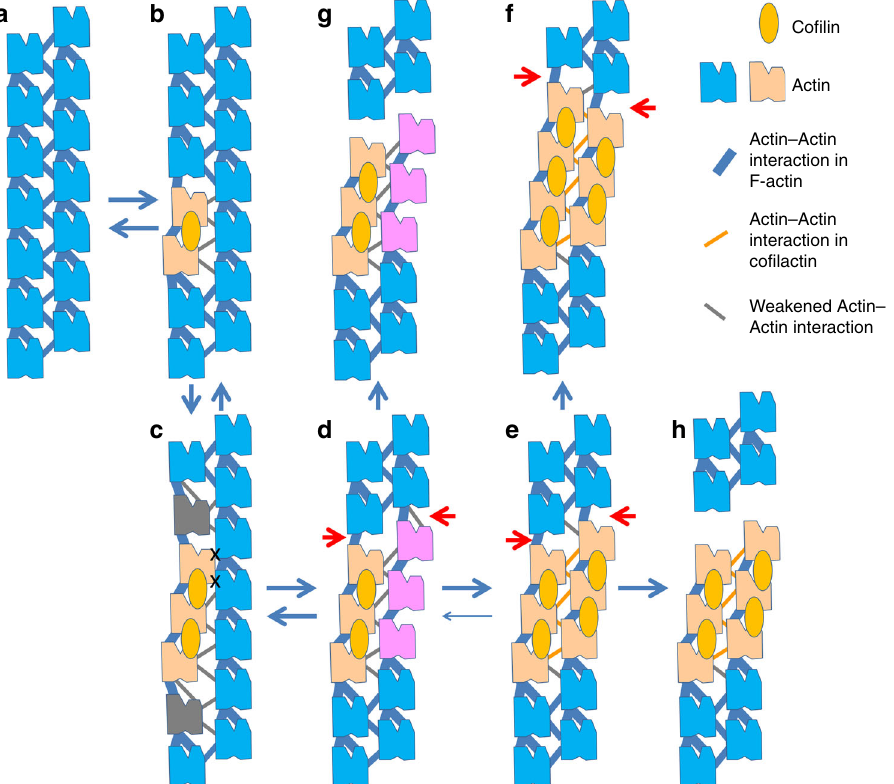
Fig. 7 Model for severing. The P-end is at the top. a F-actin. The F-form actin subunits are represented in blue. The intrastrand actin-actin contact is represented by a pair of thick blue lines, one for the ID – ID interactions and the other for the OD – ID interactions. The interstrand actin-actin contacts are also represented by thick blue lines. b Upon binding of the fi rst co fi lin molecule (orange oval) to one strand of the F-actin, two actin subunits undergo conformational transition into the C-form (camel), which is associated with a twist change in the actin strand, and therefore changes in relative positions of subunits. We assume that these positional changes weaken the interstrand contacts, as indicated by the thin gray lines. c The second co fi lin binds next to the fi rst co fi lin on the same actin strand. Collision occurs between the strands, as indicated by an “ X ” . Accumulated position mismatches between actin subunits with and without bound co fi lin may require adapter subunits at either boundary (gray). d As the size of the co fi lin-bound section in the co fi lin- bound strand increases, the helical twist transition propagates to the opposite strand. At this stage, the strain accumulated in the co fi lin-bound strand and between the strands would be relieved. The co fi lin-free actin subunits with the co fi lactin helical twist are represented in magenta. The P-end boundary of the section is a candidate for severing (red arrows). e The helical twist change in the co fi lin-free strand facilitates the binding of co fi lin molecules to the strand, forming a double-stranded co fi lin-bound cluster. The potential severing site remains (red arrows). Orange lines represent the interstrand interactions in co fi lactin (Fig. 3e). f When another co fi lin joins at the boundary of the co fi lin cluster before severing, the co fi lin cluster grows. The candidate severing site remains at the P-end boundary of the cluster (red arrowheads). g , h Severed fi